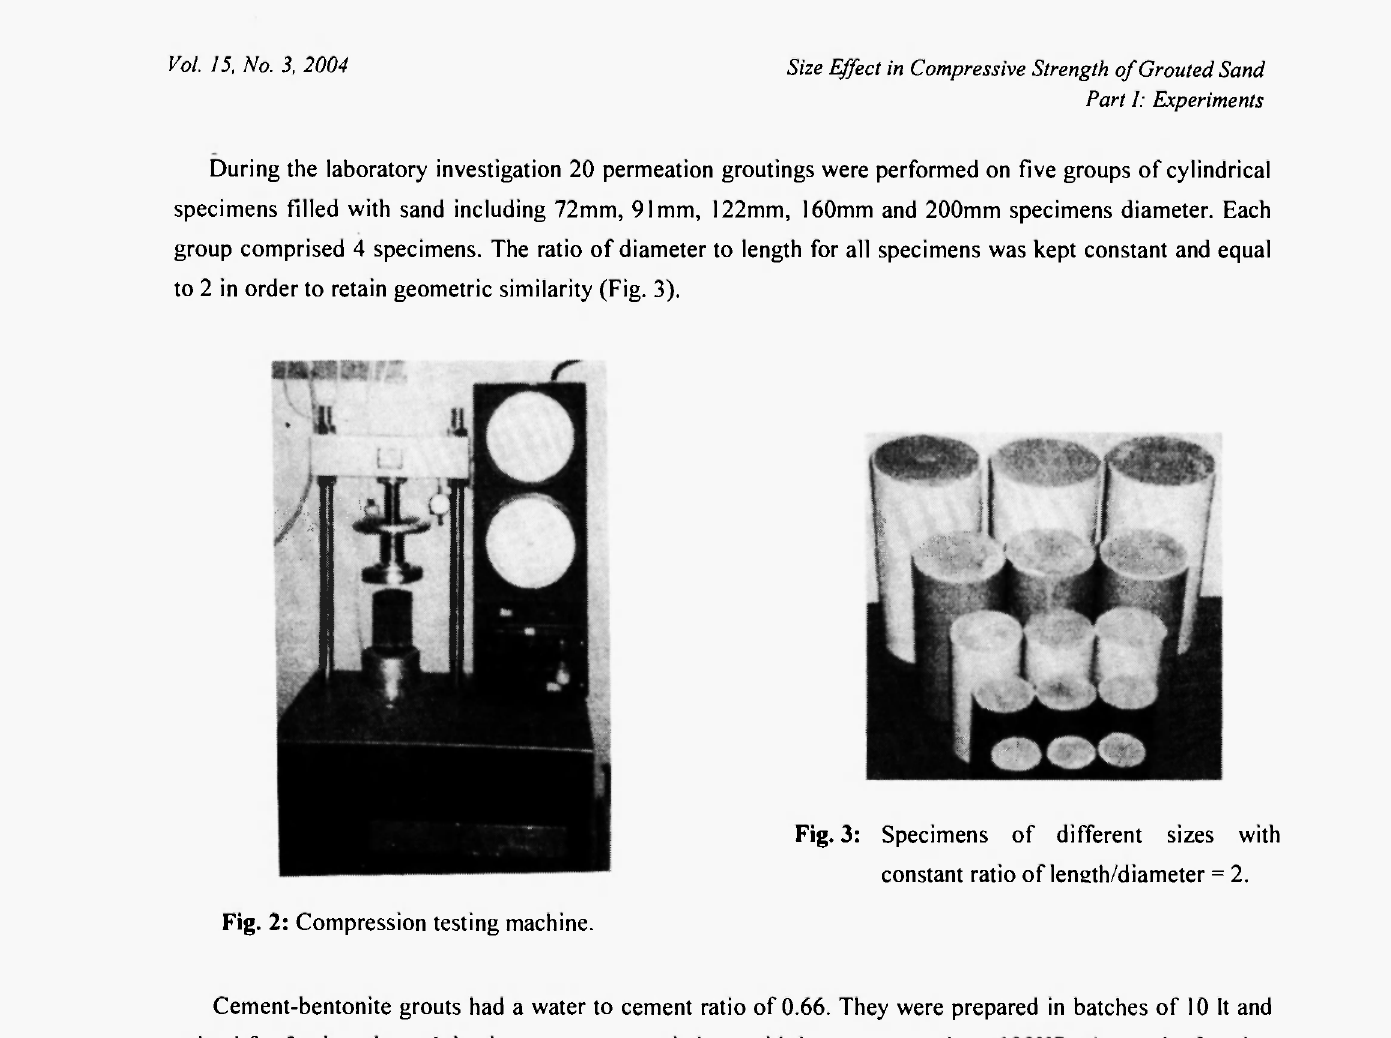
Fig. 2: Compression testing machine.